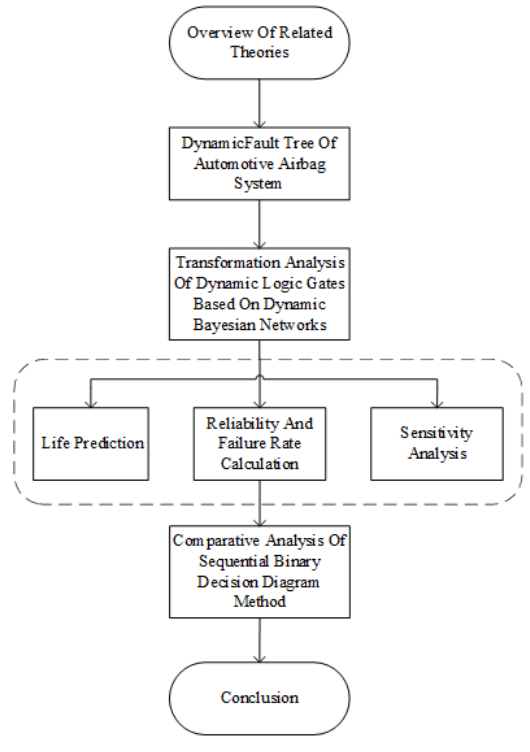
Figure 1. Structure of the article.